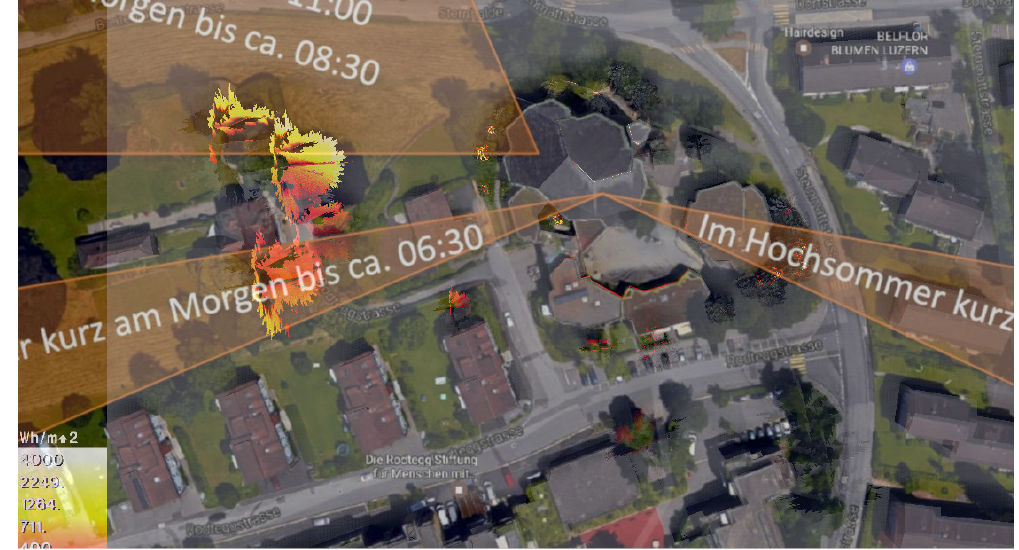
Figure 13. Reflection zones initially predicted by PV system installer (Figure 3) superimposed with plan view of simulated annual reflected irradiance obtained with the proposed method (Figure